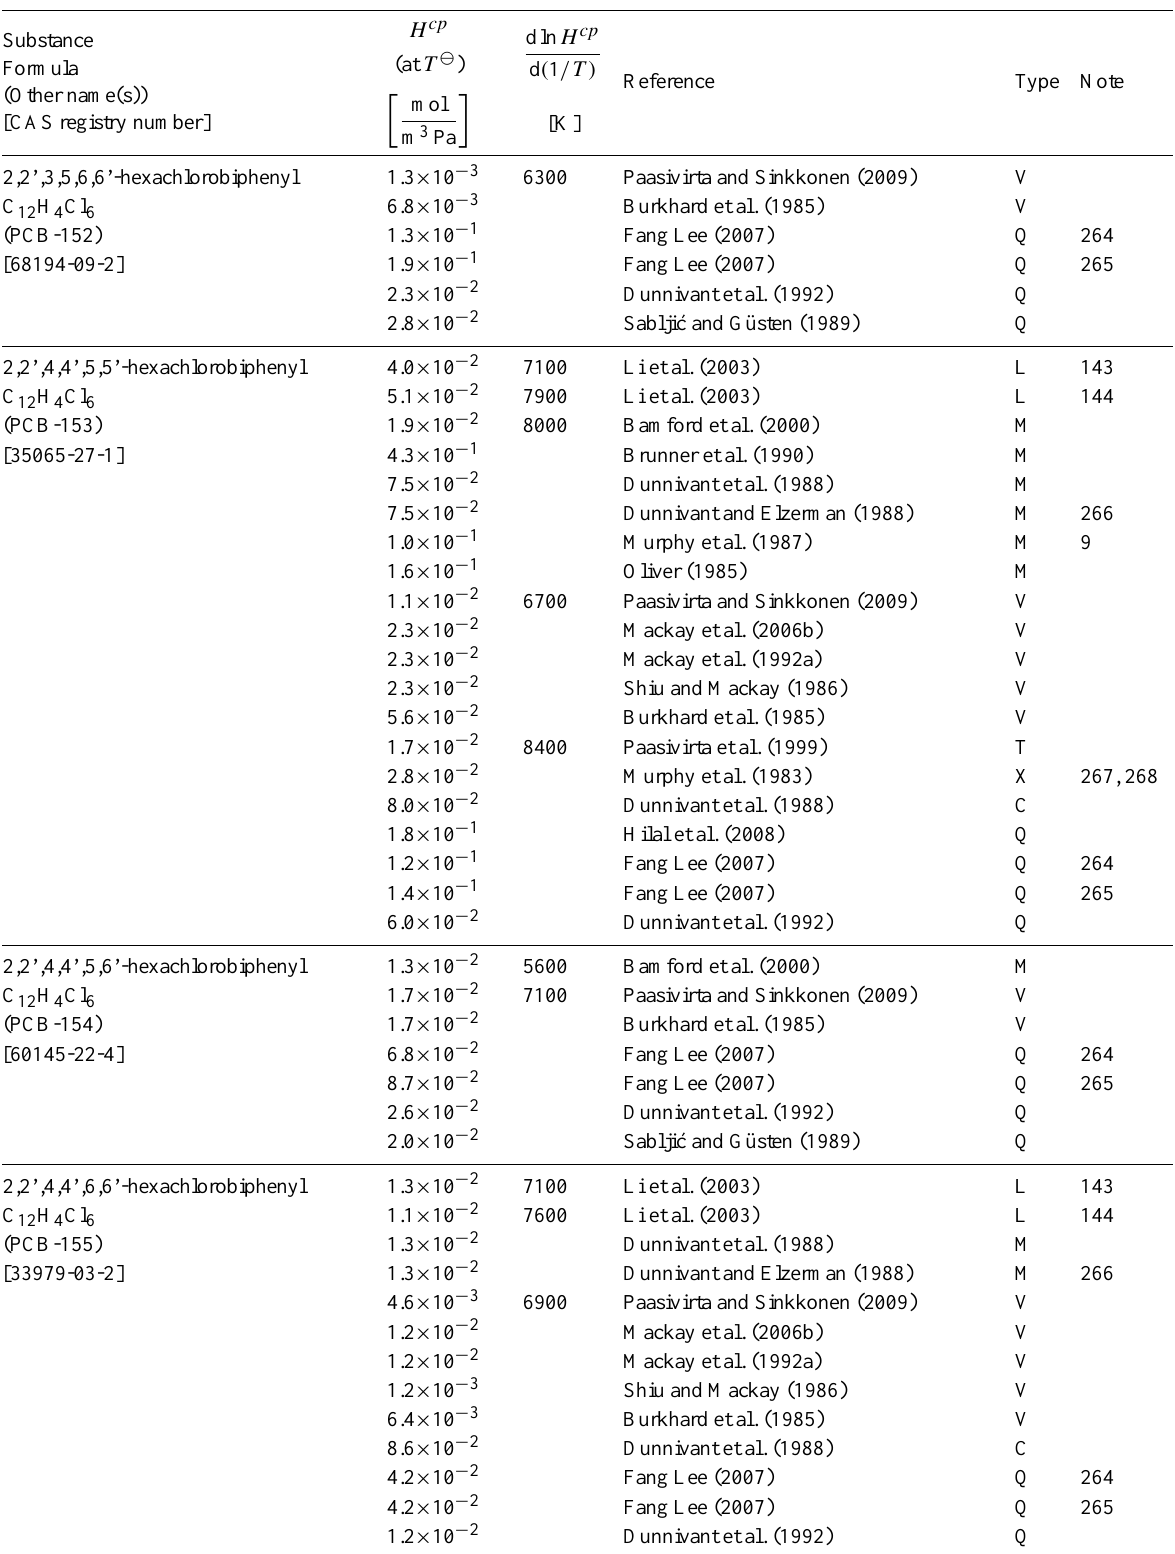
Table 6: Henry’s law constants for water as solvent